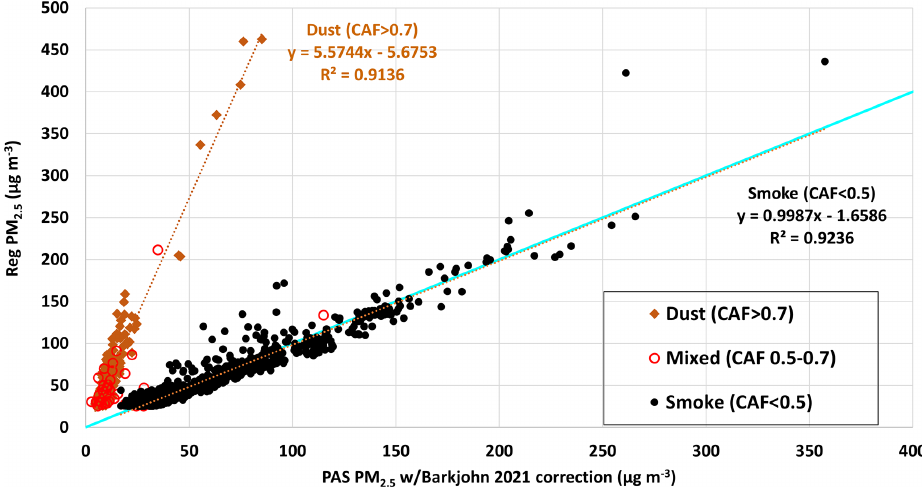
Figure 5. Regulatory PM 2 . 5 versus PAS PM 2 . 5 with the Barkjohn 2021 correction at Keeler, CA, for hours with regulatory PM 2 . 5 of > 25µgm − 3 . The data are separated by the coarse aerosol fraction (CAF), as measured by the regulatory data. Linear regression relationships are shown with dotted lines, and the light blue line shows a 1:1 relationship.